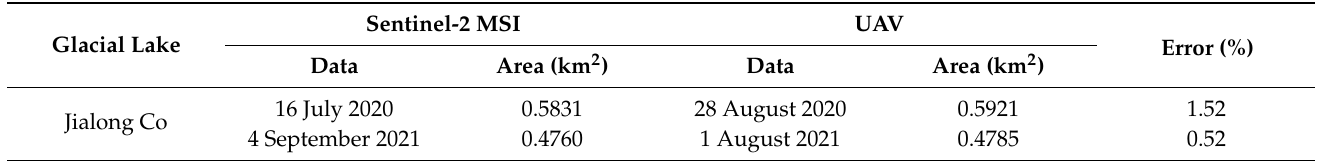
Table 3. Comparison of the outlines from UAV and Sentinel2 MSI.